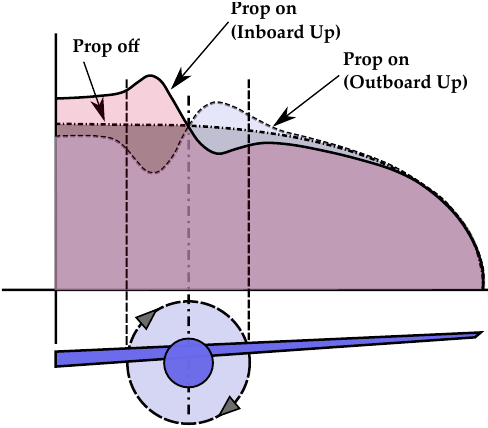
Figure 3. Effects of propeller slipstream on wing